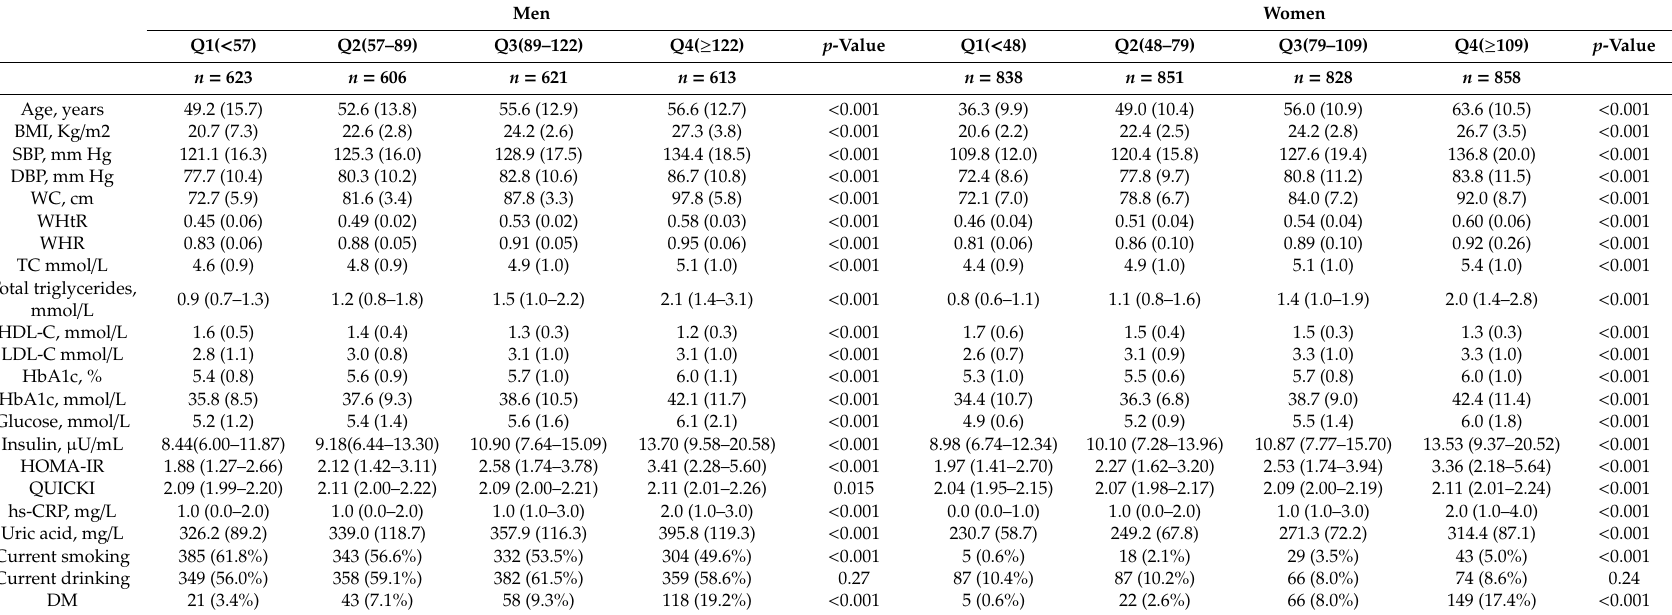
Table 1. Demographic and clinical characteristics of study participants ( n = 5838) across Chinese visceral adiposity index (CVAI) quartiles in